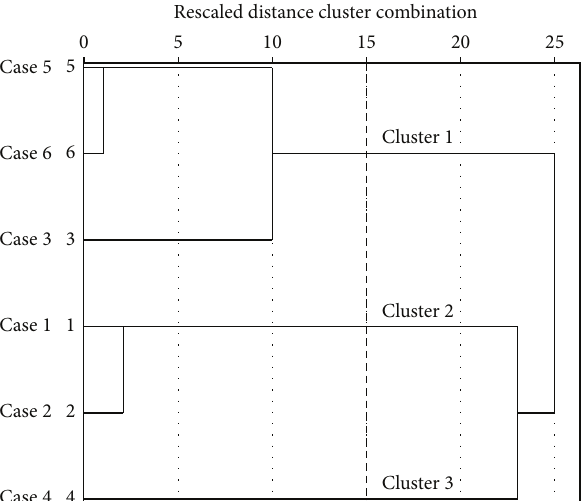
Figure 6: Cluster of the six sampling stations.